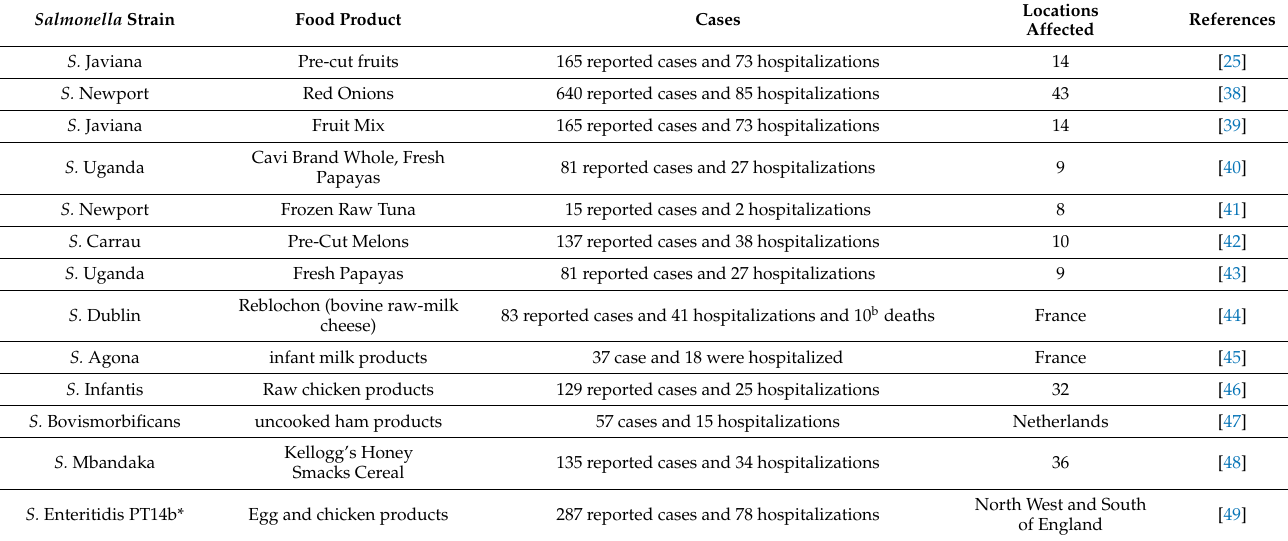
Table 3. Food products involved in Salmonella outbreaks in Europe and United